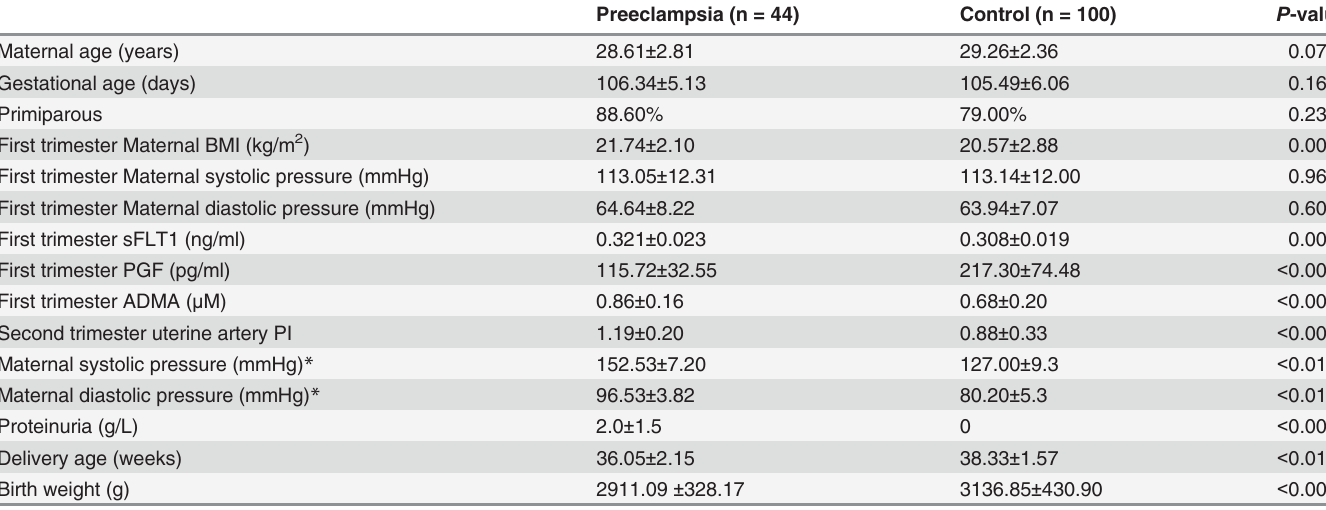
Table 1. Demographic characteristics and serological markers (sFLT1, PGF and ADMA) in the preeclampsia and control